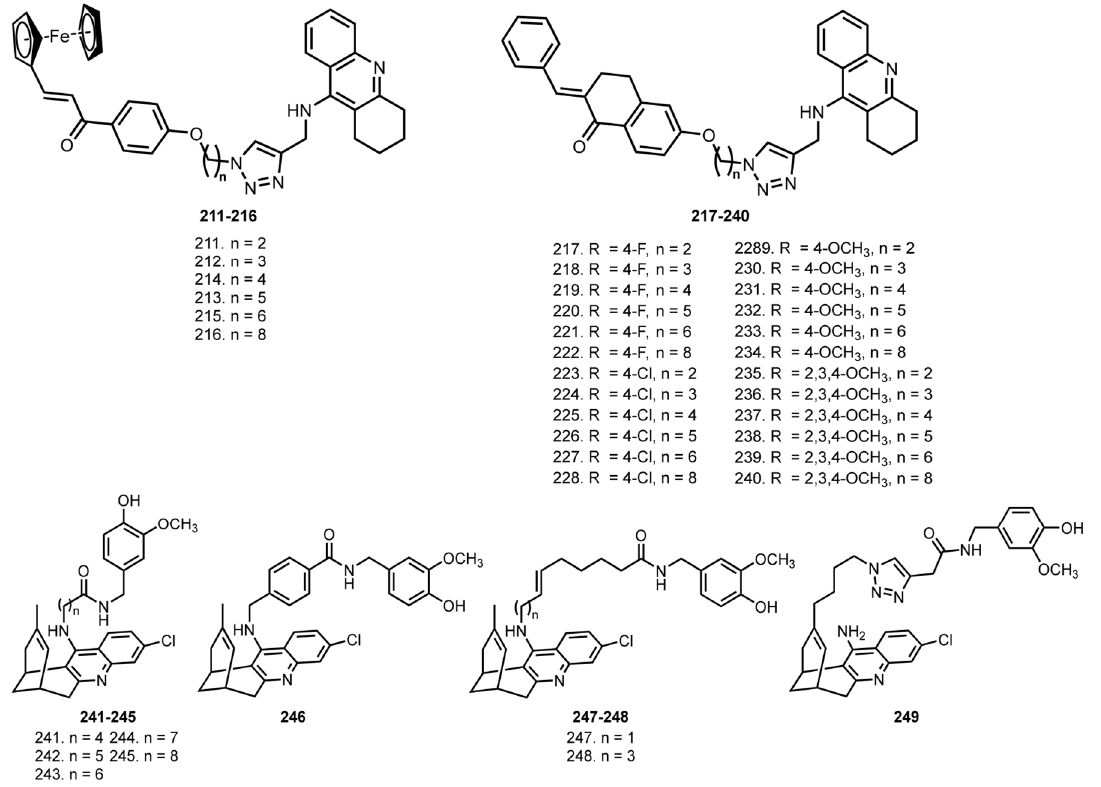
Figure 8. THA–triazole–chalkone conjugates 211 – 240 [57], huprine Y–capsaicin hybrids 241 – 249 [58].